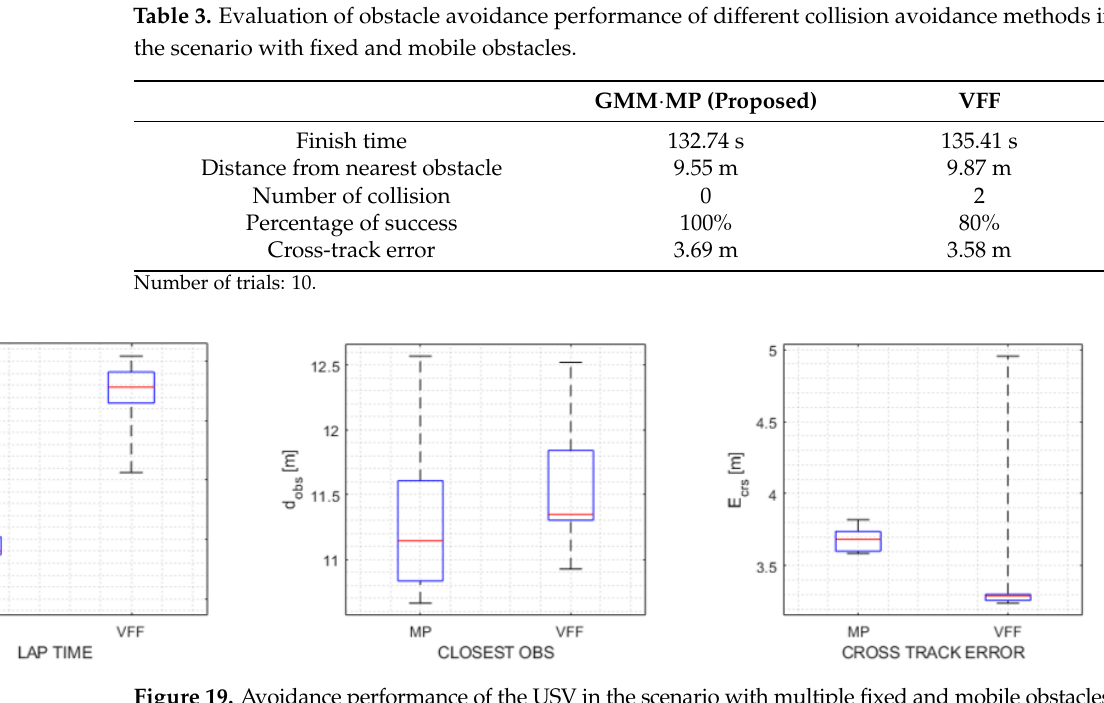
Figure 19. Avoidance performance of the USV in the scenario with multiple fixed and mobile